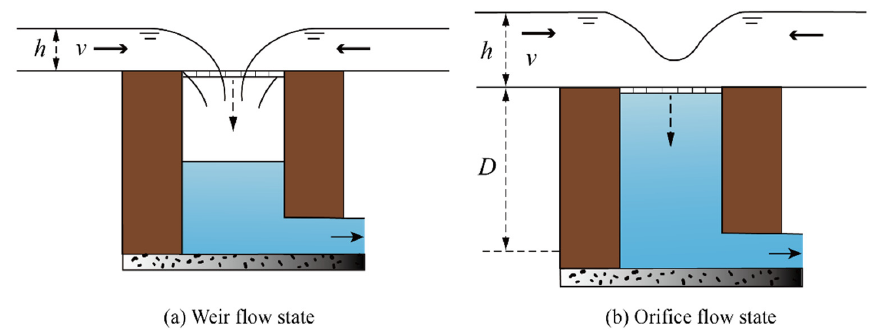
Figure 5. Sketch of inlet flow state. ( a ) and ( b ) are weir pattern and orifice pattern of inlet, respec-